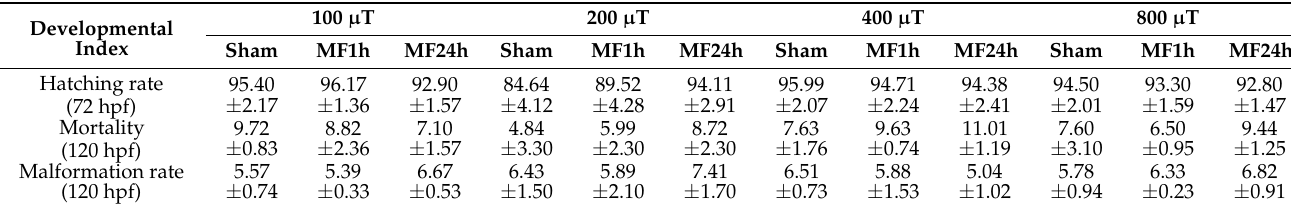
Table 1. Effects of 50-Hz MF exposure on embryonic development of zebrafish ( M ± SD